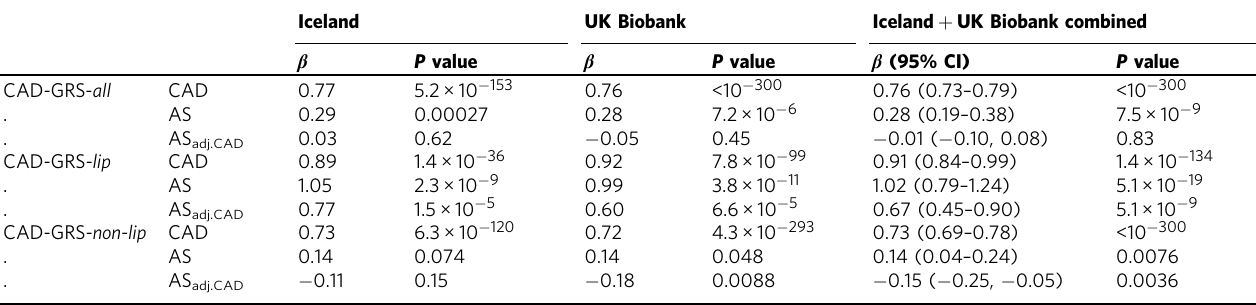
Table 4 The association of coronary artery disease genetic risk score with aortic valve stenosis Iceland UK